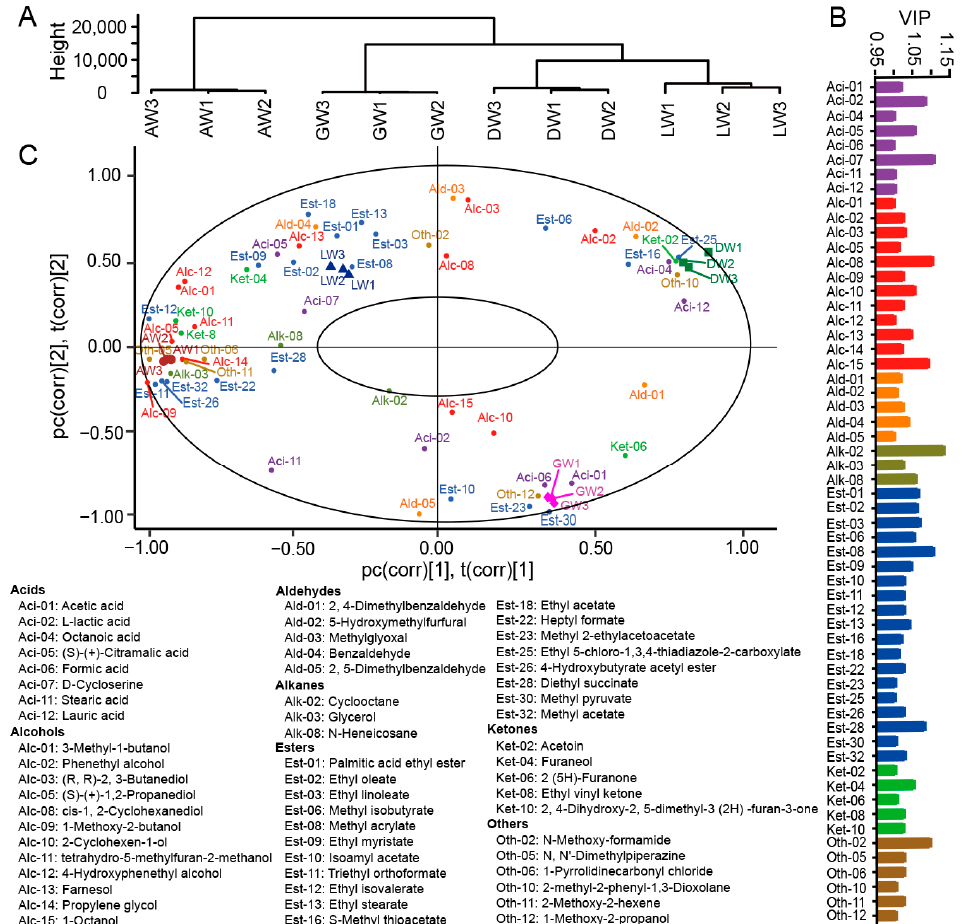
Figure 5. Analysis of volatile compounds in rice wine samples fermented by different regional Qus. ( A ) Hierarchical clustering of volatile compounds was performed using the method of average linkage; ( B ) the variables important in the projection (VIP) values of the 58 important volatile compounds (VIP > 1.00); ( C ) biplot of volatile compounds with VIP value > 1.00 from partial least squares discriminant analysis (PLS-DA) model among different samples.